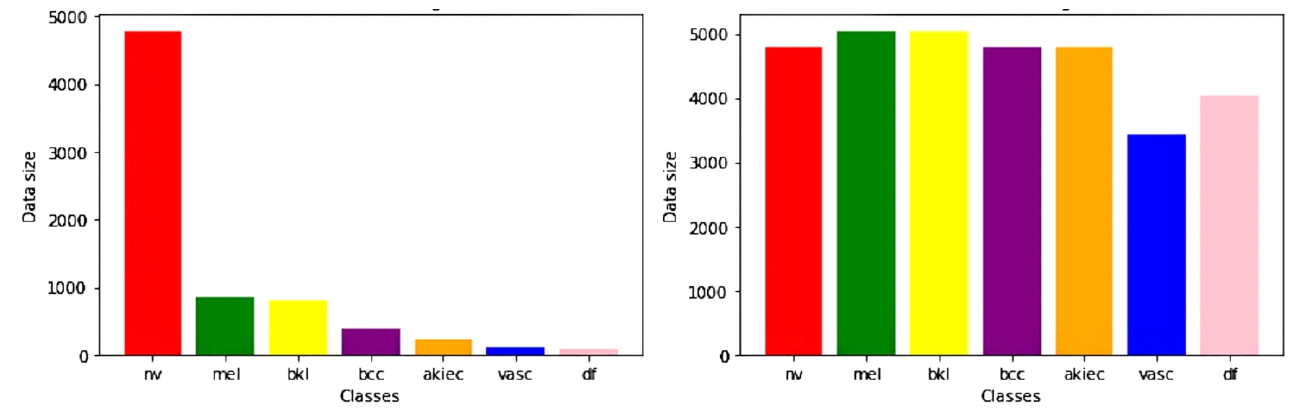
Figure 3. Class distribution before and after data augmentation.